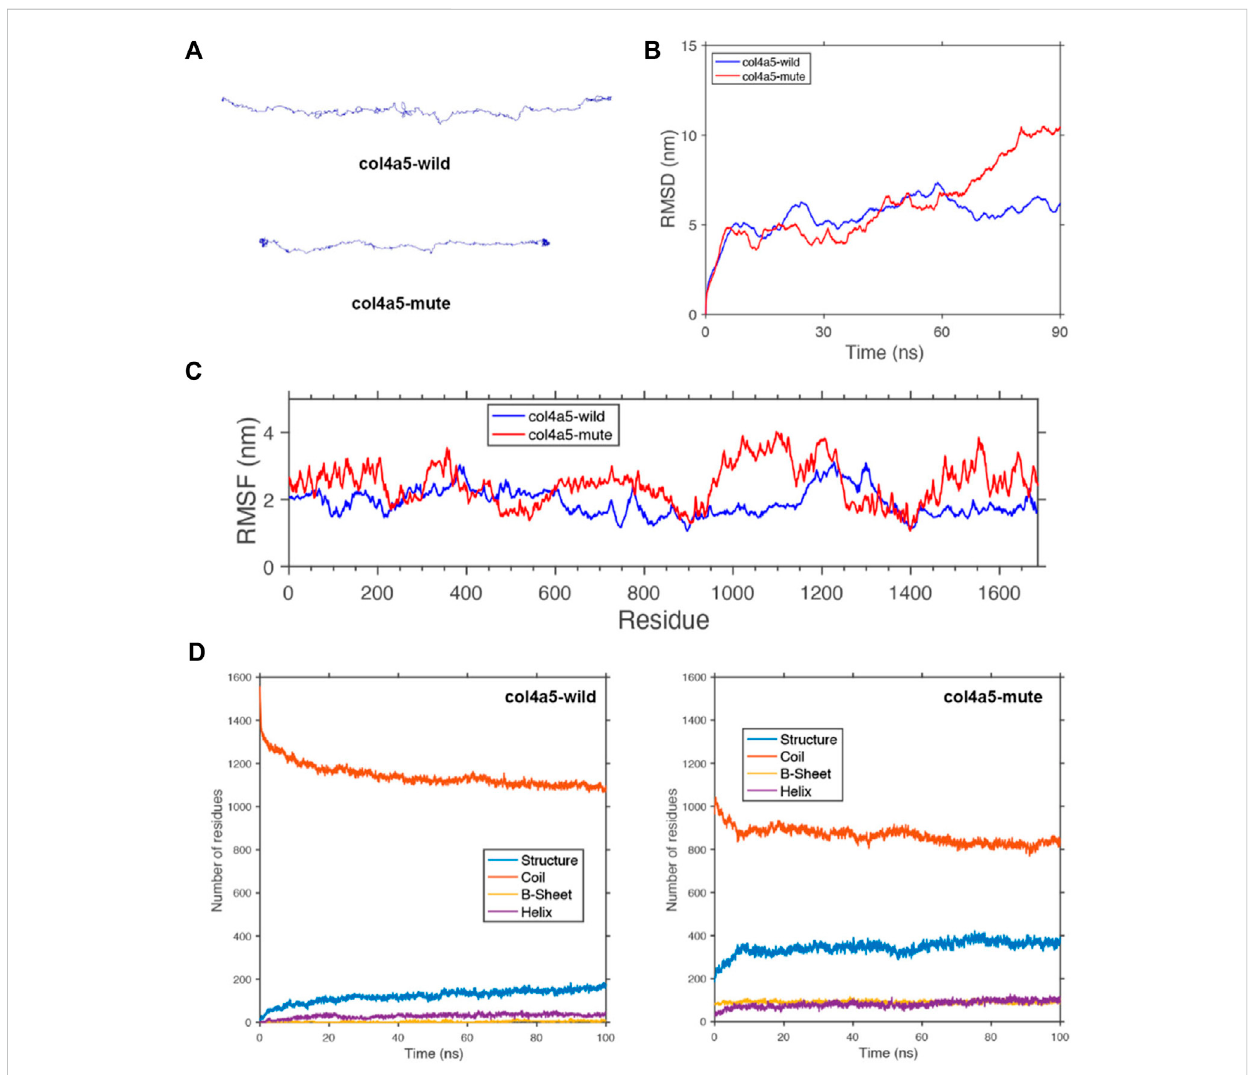
FIGURE 5 Protein molecular dynamics simulation of the α 5(IV). (A) The conformation of the COL4A5 -wild and -mute chains through molecular dynamics simulations at90 ns. (B) RMSDof COL4A5 -wildand-mute chainsduring90 ns. (C) RMSFofeachaminoacid ofthe COL4A5 -wildand-mute chainsfrom 80 ns to 90 ns. (D) The numbers of the secondary structures of the COL4A5 -wild and -mute chains during 100